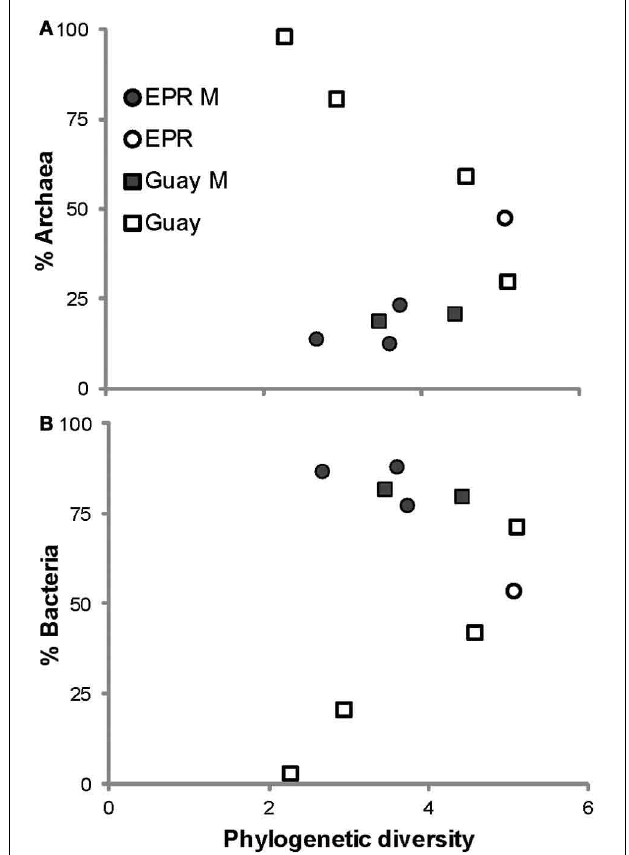
FIGURE 4 | Relationships between the proportions of Archaea (A) or Bacteria (B) within vent-specific 16S rRNA sequences against estimates of phylogenetic diversity from the indicated sample site. M, macrofauna-assocated sites, EPR, 9 ◦ N East Pacific Rise; Guay, Guaymas